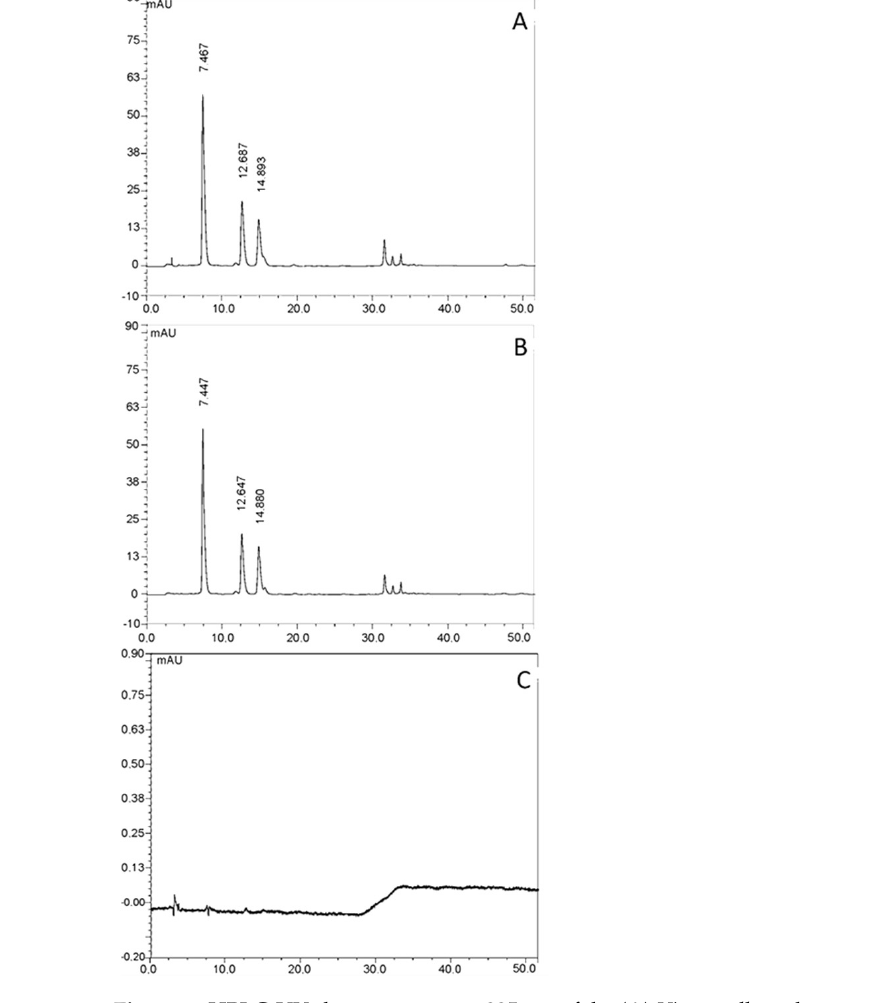
Figure 2. HPLC-UV chromatogram at 325 nm of the ( A ) Viscum album dry extract (VA_DE), ( B ) Viscum album ethanolic dry extract hydrogel (VA_DEH), and ( C ) vector control (VC, hydrogel without extract). Peaks 1, 2, and 3 correspond to 3- O -caffeoylquinic acid, 4- O -caffeoylquinic acid, and 5- O -caffeoylquinic acid, respectively.